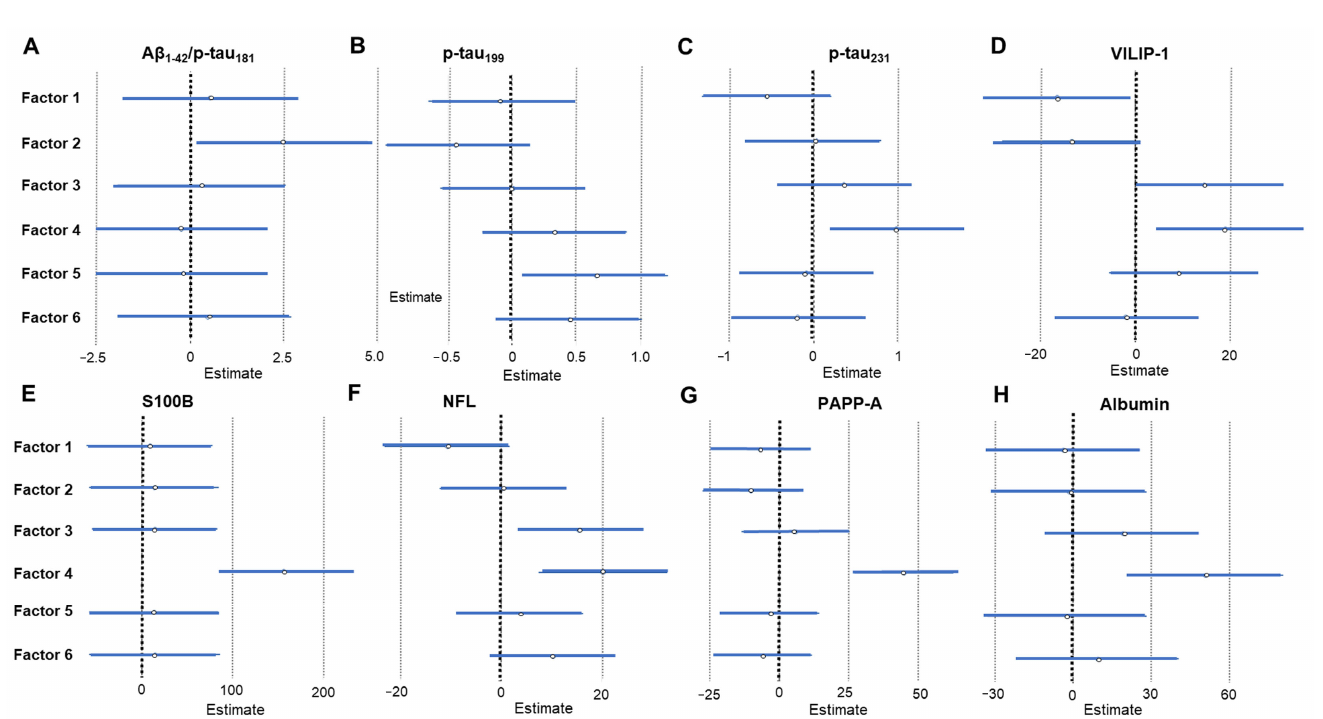
Figure 7. Association of CSF AD biomarkers – A β 1–42 /p-tau 181 ratio ( A ), p-tau 199 ( B ), p-tau 231 ( C ), VILIP-1 ( D ), S100B ( E ), NFL ( F ), PAPP-A ( G ), and albumin ( H ) with plasma macro- and microelement groups revealed by the PCA. Effect sizes and 95% confidence intervals are given by linear regression analysis (statistically significant factors are considered those represented with horizontal lines that do not intersect with the vertical line at 0). Factor 1; plasma Ca, Co, Cu, Mg, Mn, Na, P, S, Se, Tl, and Zn; Factor 2; plasma B, Cd, Li, Mo, and Pb; Factor 3; plasma As and Hg; Factor 4; plasma Ni; Factor 5; plasma Sr; Factor 6; plasma